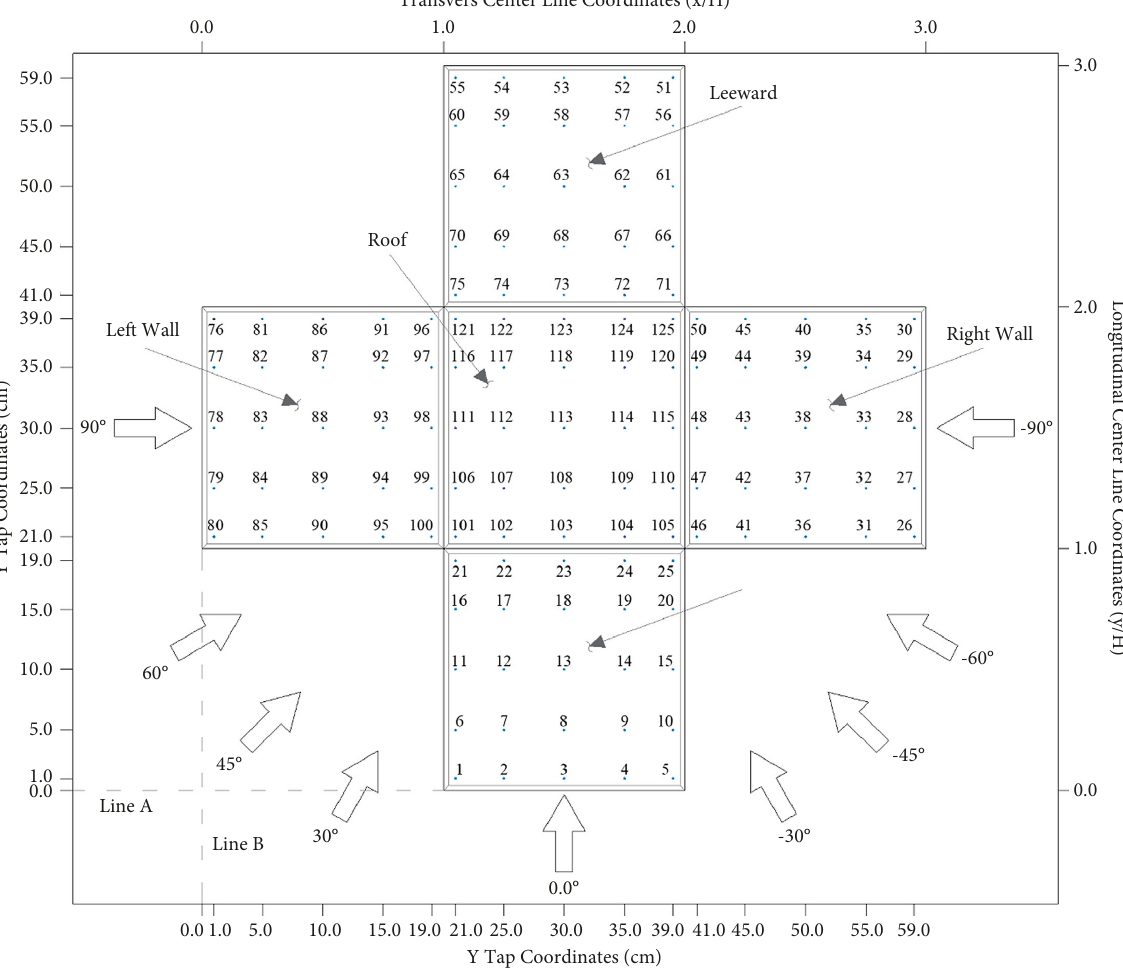
Figure 8: Coordinates of the taps located in the low-rise building tested in wind tunnel and wind directions. Table 1: Training, validation, and test